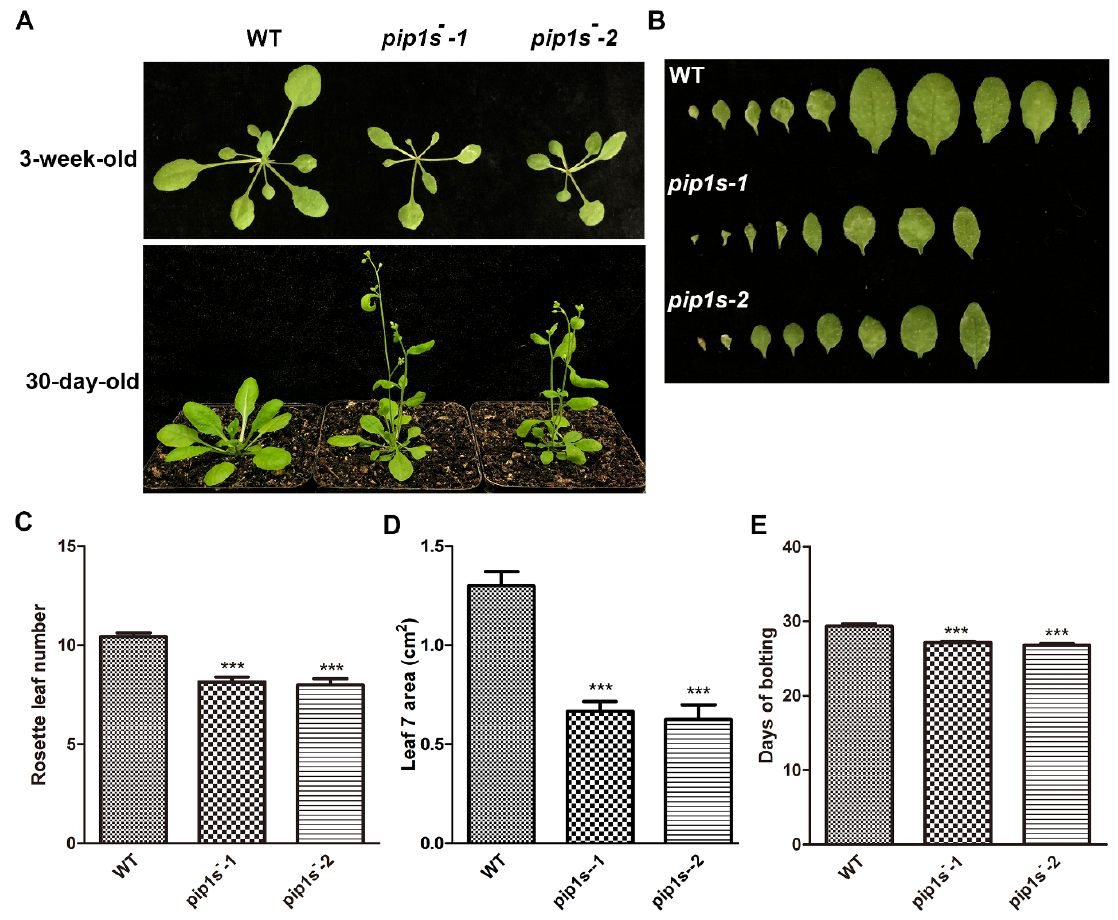
Figure 2. The pip1s – mutants are defective in vegetative growth in Arabidopsis . ( A ) The growth phenotypes of the WT, pip1s – -1 and pip1s – -2 plants. The 10-day-old seedlings grown on 1/2 MS plates were transplanted to soil and grown at 22 °C with 16 h/8 h light/dark. Photographs were captured 30 days or 3 weeks after transplantation. ( B ) Morphological phenotype of the leaves of 3-week-old WT, pip1s – -1 and pip1s – -2 plants. ( C ) Number of rosette leaves produced per plant of the WT, pip1s – -1 and pip1s – -2 plants after transplanted for 3 weeks. ( D ) The area of the seventh rosette leaf of the WT, pip1s – -1 and pip1s – -2 plants after transplanted for 3 weeks. The area was determined with ImageJ software. ( E ) Days to start bolting of the WT, pip1s – -1 and pip1s – -2 plants. Bars represent the means ± SD of three biological replicates. Significant differences were determined by one-way analysis of variance (ANOVA) followed by Duncan’s multiple range test (*** p < 0.0001).